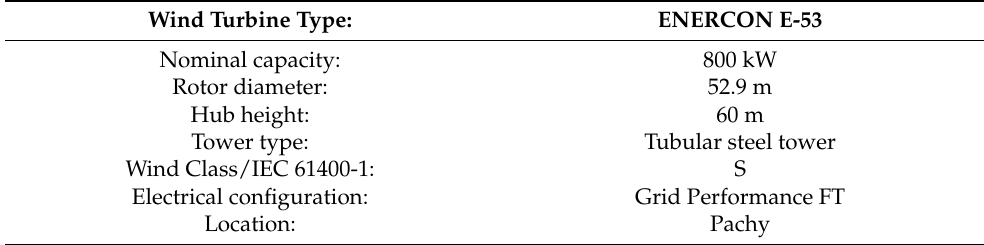
Table 1. Main characteristics of installed wind turbine.